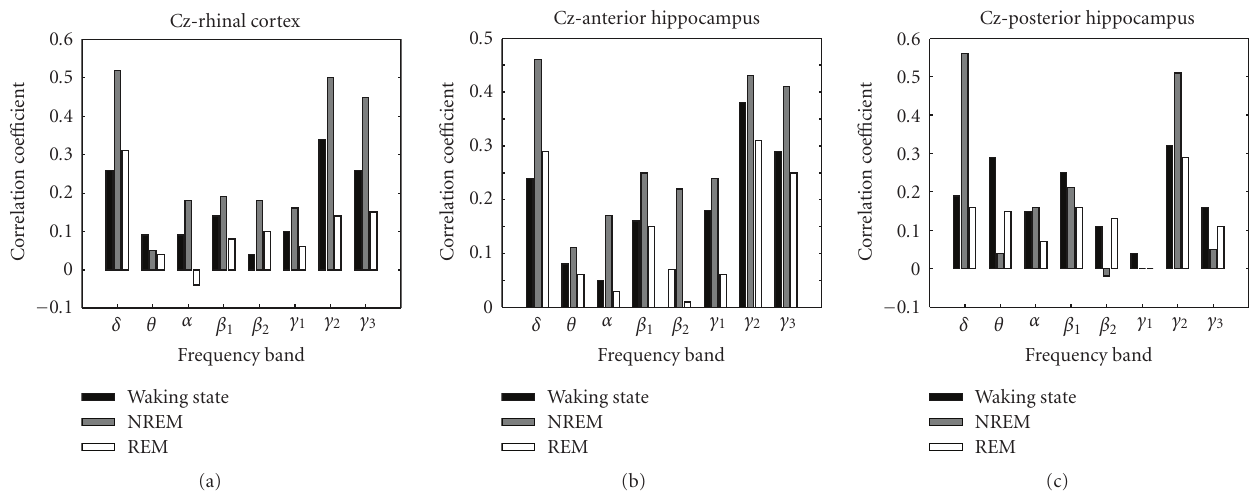
Figure 2: Pearson’s correlation coe ffi cient (Fisher z -transformed) between power densities in scalp EEG (C3/C4) versus medial temporal locations; averages across subjects are depicted. Both in the δ and in higher ( α and γ 2 ) frequency range, correlation values were maximal during NREM